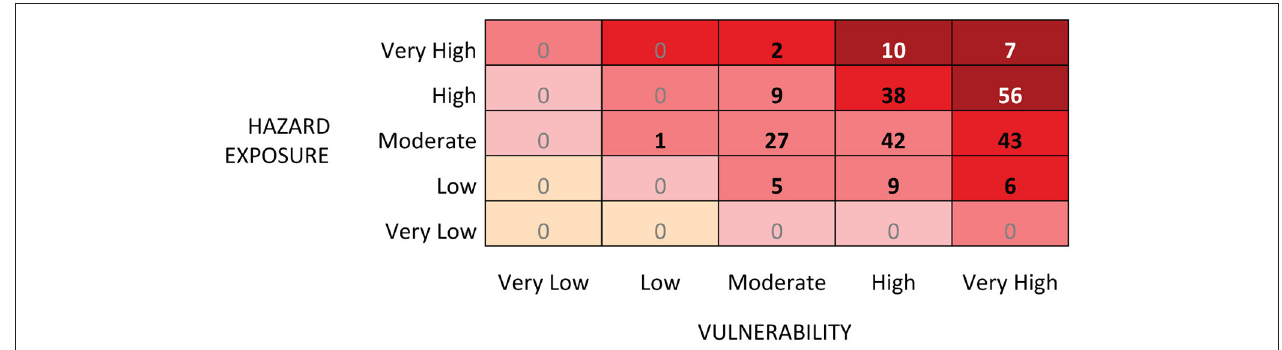
FIGURE 7 | Results of the matrix classification. The number in the cells correspond to the number of municipalities that were classified in each combination of the hazard exposure and vulnerability sub-components.